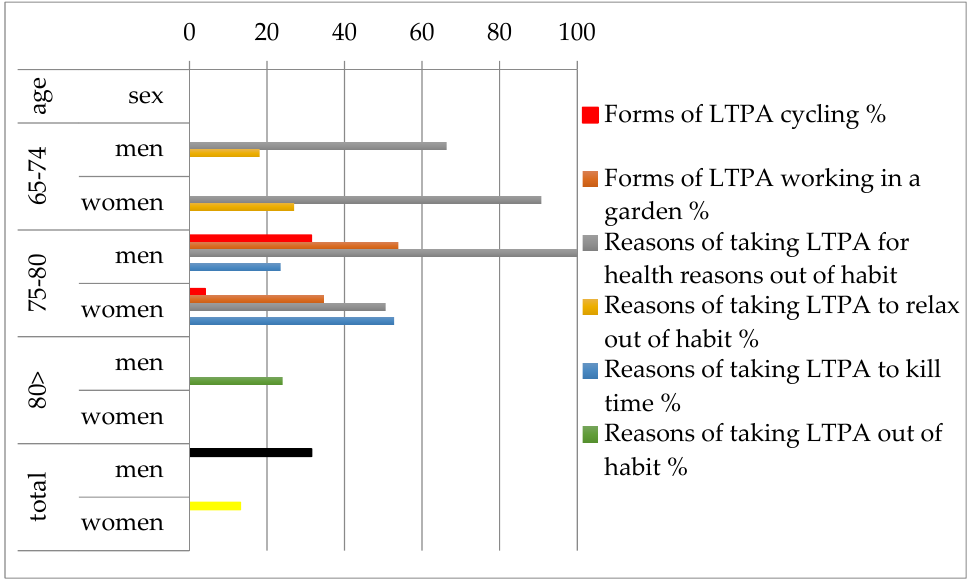
Figure 1. Statistically significant differences between men and women in LTPA forms and motives in terms of age.